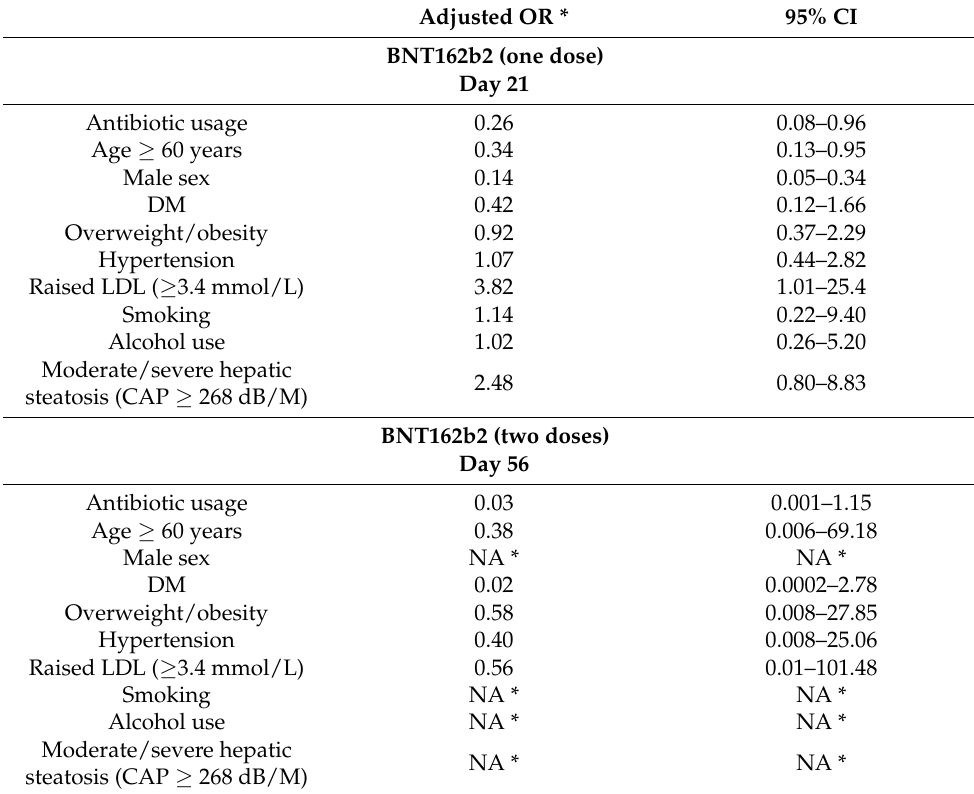
Table 3. Risk factors for the seroconversion of neutralizing antibody among BNT162b2